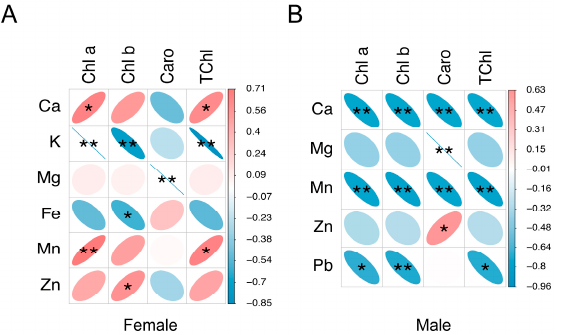
Figure 6. Correlation coefficients between nutritional elements in the chloroplast and cell nuclei fraction and photosynthetic pigments of L. cubeba female ( A ) and male ( B ) leaves under the control and Pb treatments. *, p < 0.05; **, p < 0.01.